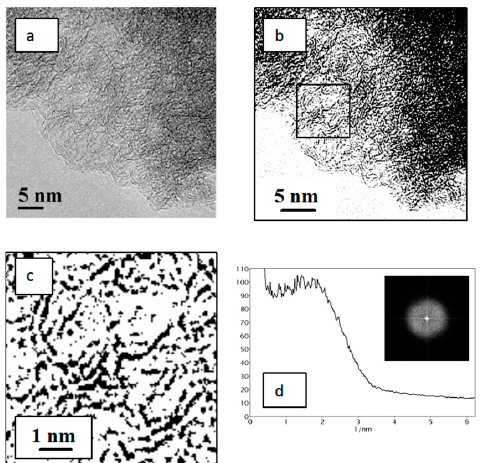
Figure 3. TEM image of the carbon material after thermal treatment at 900 °C (CO 2 ) of the CM sample obtained by carbonization at 400 °C of dehydrochlorinated PVC ( a ); the same TEM image in the binary form ( b ); its scaled-up central part marked by a square ( c ); RCIP ( d ) obtained by processing the FFT image that is displayed in the inset (units on the x axis correspond to the inverse distance between graphene layers, 1/nm).